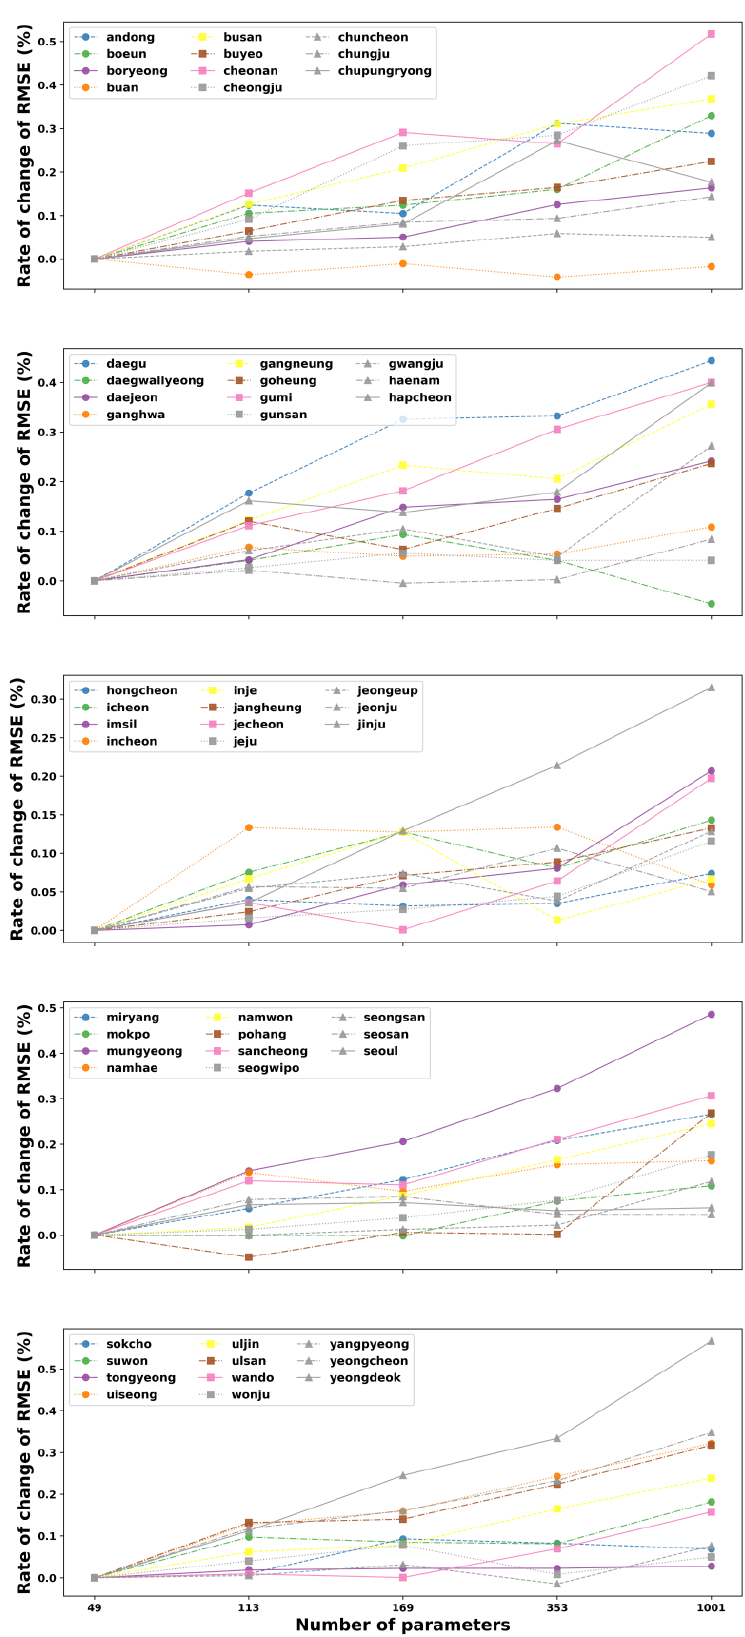
Figure 4. The rate of change of the mean RMSE of the 3-hidden layer ANN corresponding to 49, 113, 169, 353, and 1001 trainable parameters for the test data for all 55 stations in South Korea.